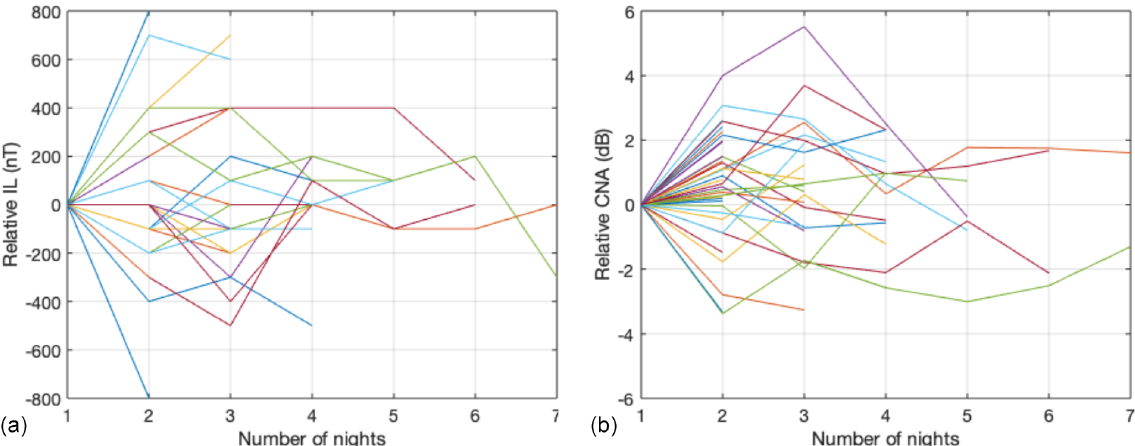
Figure 6. An event-by-event evolution of the IL index (a) and the CNA index (b) during multi-night events. Each event is represented by one curve, whether the event lasts for 2 or 7 nights in a row. The minimum IL value and the maximum CNA value reached during the first night have been subtracted. As the IL minima have been rounded to the nearest full 100nT, some of the event evolution lines appear on top of each other, making the plot look less busy than the CNA plot, although the number of events is equal in both panels.